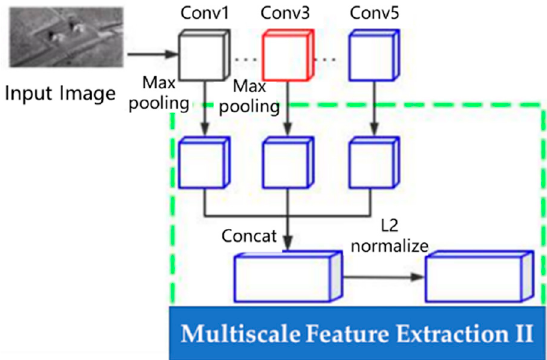
Figure 3. Multiscale feature extraction II.